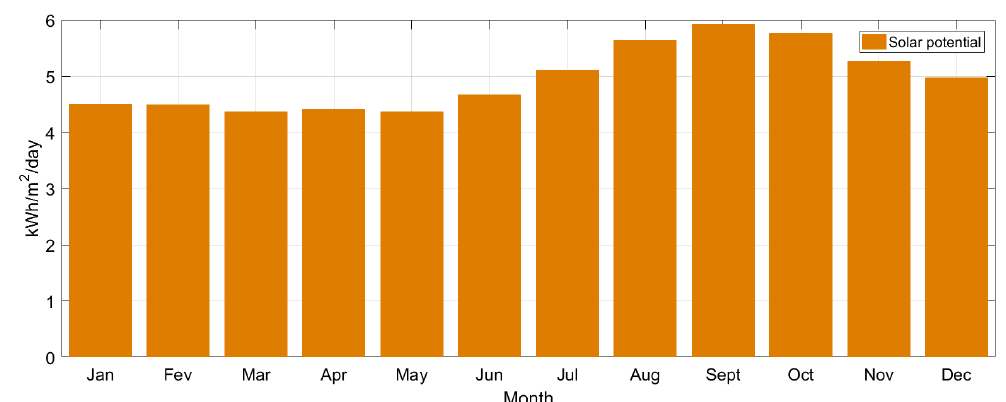
Figure 4. Solar potential in the Tapajós-Arapiuns Extractive Reserve.